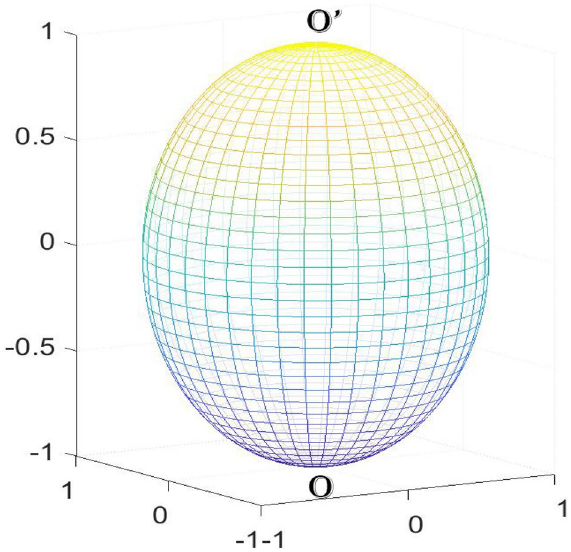
1 latitude. The resistances in the longitude −